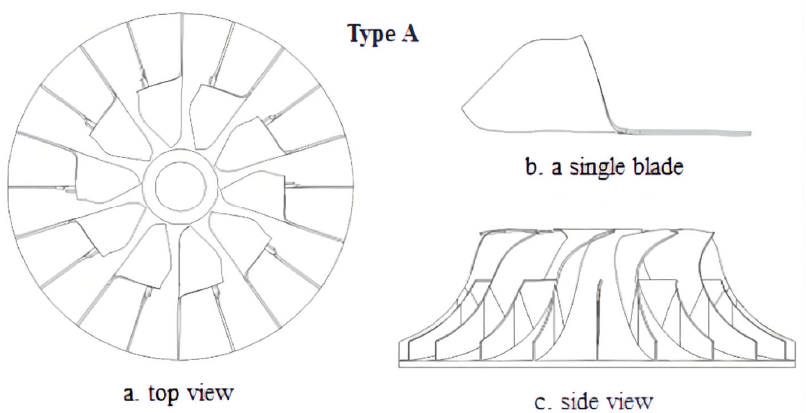
Figure 4. Blade configuration of type A.